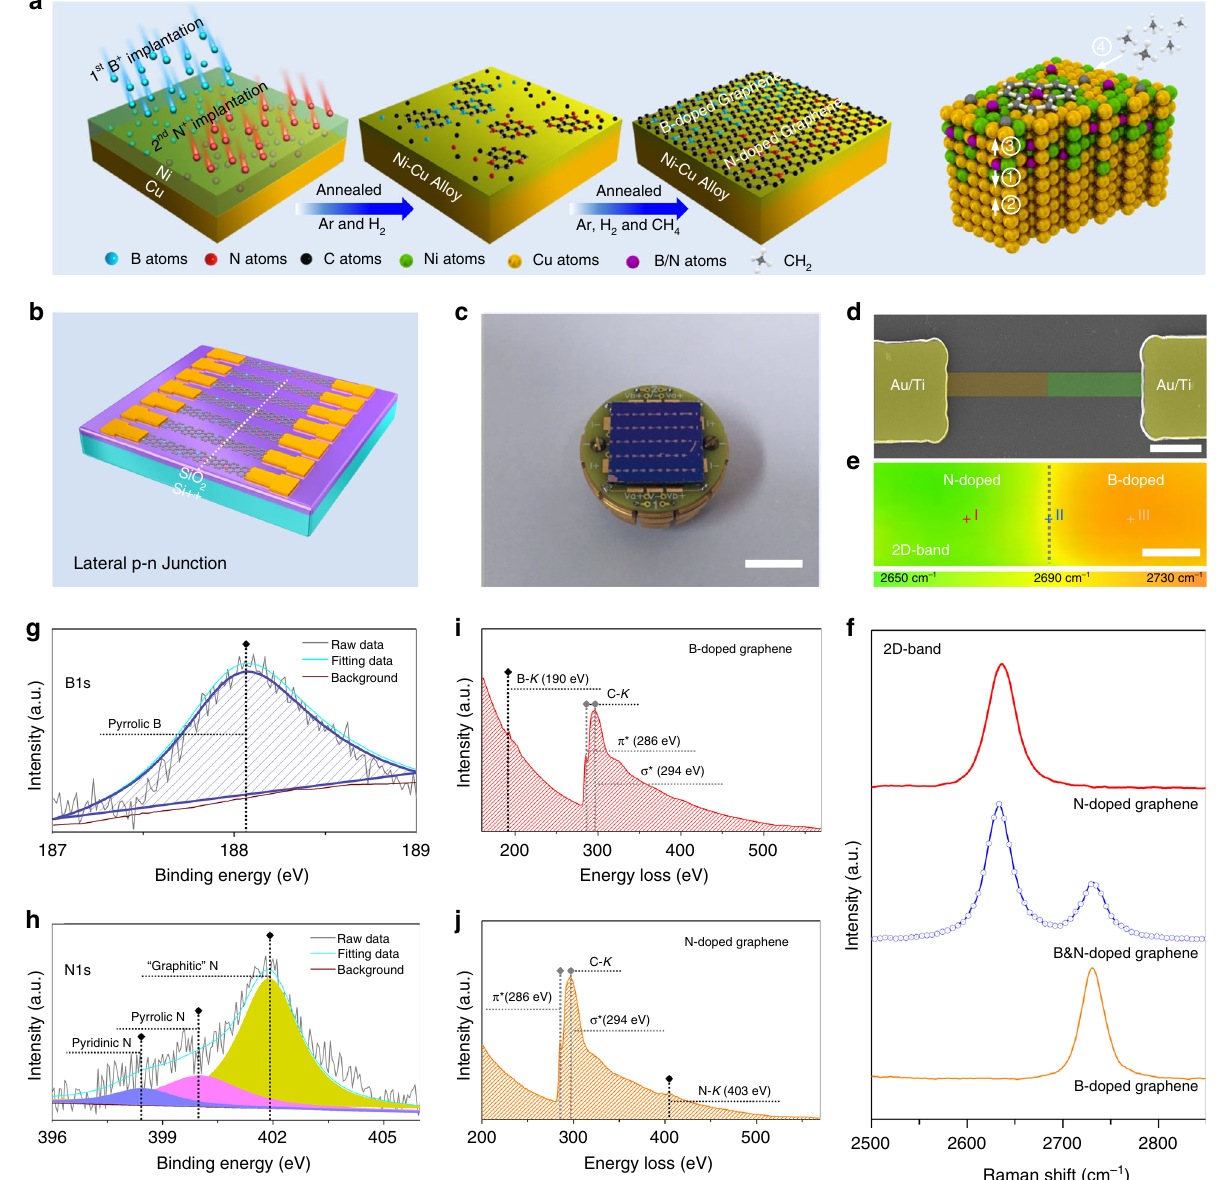
Fig. 1 Characterization of the seamless lateral graphene p – n junction. a Schematic diagrams showing the synthesis process of the seamless lateral graphene p – n junctions. 1, 2, and 3 represent diffusion of Ni, Cu, and dopant (B or N) atoms, and 4 represents carbon atoms supplied by the decomposition of CH 4 . b Schematic diagram of the graphene photodetector array constructed on the seamless lateral graphene p – n junction. c A real image of the graphene photodetector array on the seamless lateral graphene p – n junction. The scale bar is 1 cm. d Pseudo-color SEM image of the seamless lateral graphene p – n junction device. The scale bar is 4 μ m. e 2D peak map of the junction area of the lateral graphene p – n junction showing the B-doped graphene region (orange, B ion implantation using a fl uence of 4 × 10 16 atoms/cm 2 ) and N-doped graphene region (green, N ion implantation with a fl uence of 4 × 10 16 atoms/cm 2 ). The scale bar is 1 μ m. f Raman spectra acquired from three different regions indicated in ( e ): (I) N-doped graphene portion (orange), (II) Junction location (blue), and (III) B-doped graphene region (red). g High-resolution XPS B-1 s spectrum of the B-doped graphene fi lm. h High-resolution XPS N-1 s spectrum of the N-doped graphene fi lm. EELS images of i , B-doped graphene and j , N-doped graphene Controllable doping in the synthesis of B-doped and N-doped decrease from ~2680 to ~2666 cm − 1 is observed from the N- graphene . In ion implantation, the dopant concentration can be doped graphene (Fig. 2b). Electrochemical charging has been controlled accurately. Figure 2a displays the representative Raman shown to be an ef fi cient doping technique for graphene, although spectra of the B-doped graphene (red lines) and the N-doped it may be dif fi cult in practical device applications 39 . Hole doping with a positive potential upshifts the 2D band but electron doping graphene (orange lines) for different ion implantation fl uences. downshifts the 2D band, which is in agreement with our in situ B Compared to the pristine graphene, B upshifts the 2D band and N and N doping described here. Since the G band always stiffens for downshifts it. As the implantation fl uence is increased from 4 × doping levels below 0.6 eV 40 , the position of the G band always 10 15 to 4 × 10 16 atoms/cm 2 , the 2D band of the B-doped graphene shifts gradually from ~2708 to ~2720 cm − 1 , whereas a monotonic shifts to larger wavenumbers independent of the doping type, NATURE COMMUNICATIONS| (2018) 9:5168